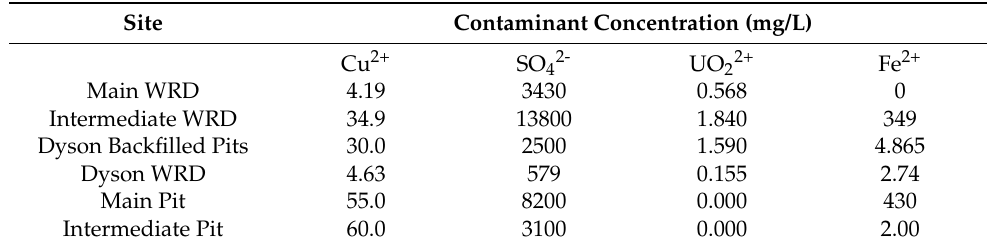
Table 6. Contamination release schedule from distributed sources—simulated measurements for testing (as sources are known).